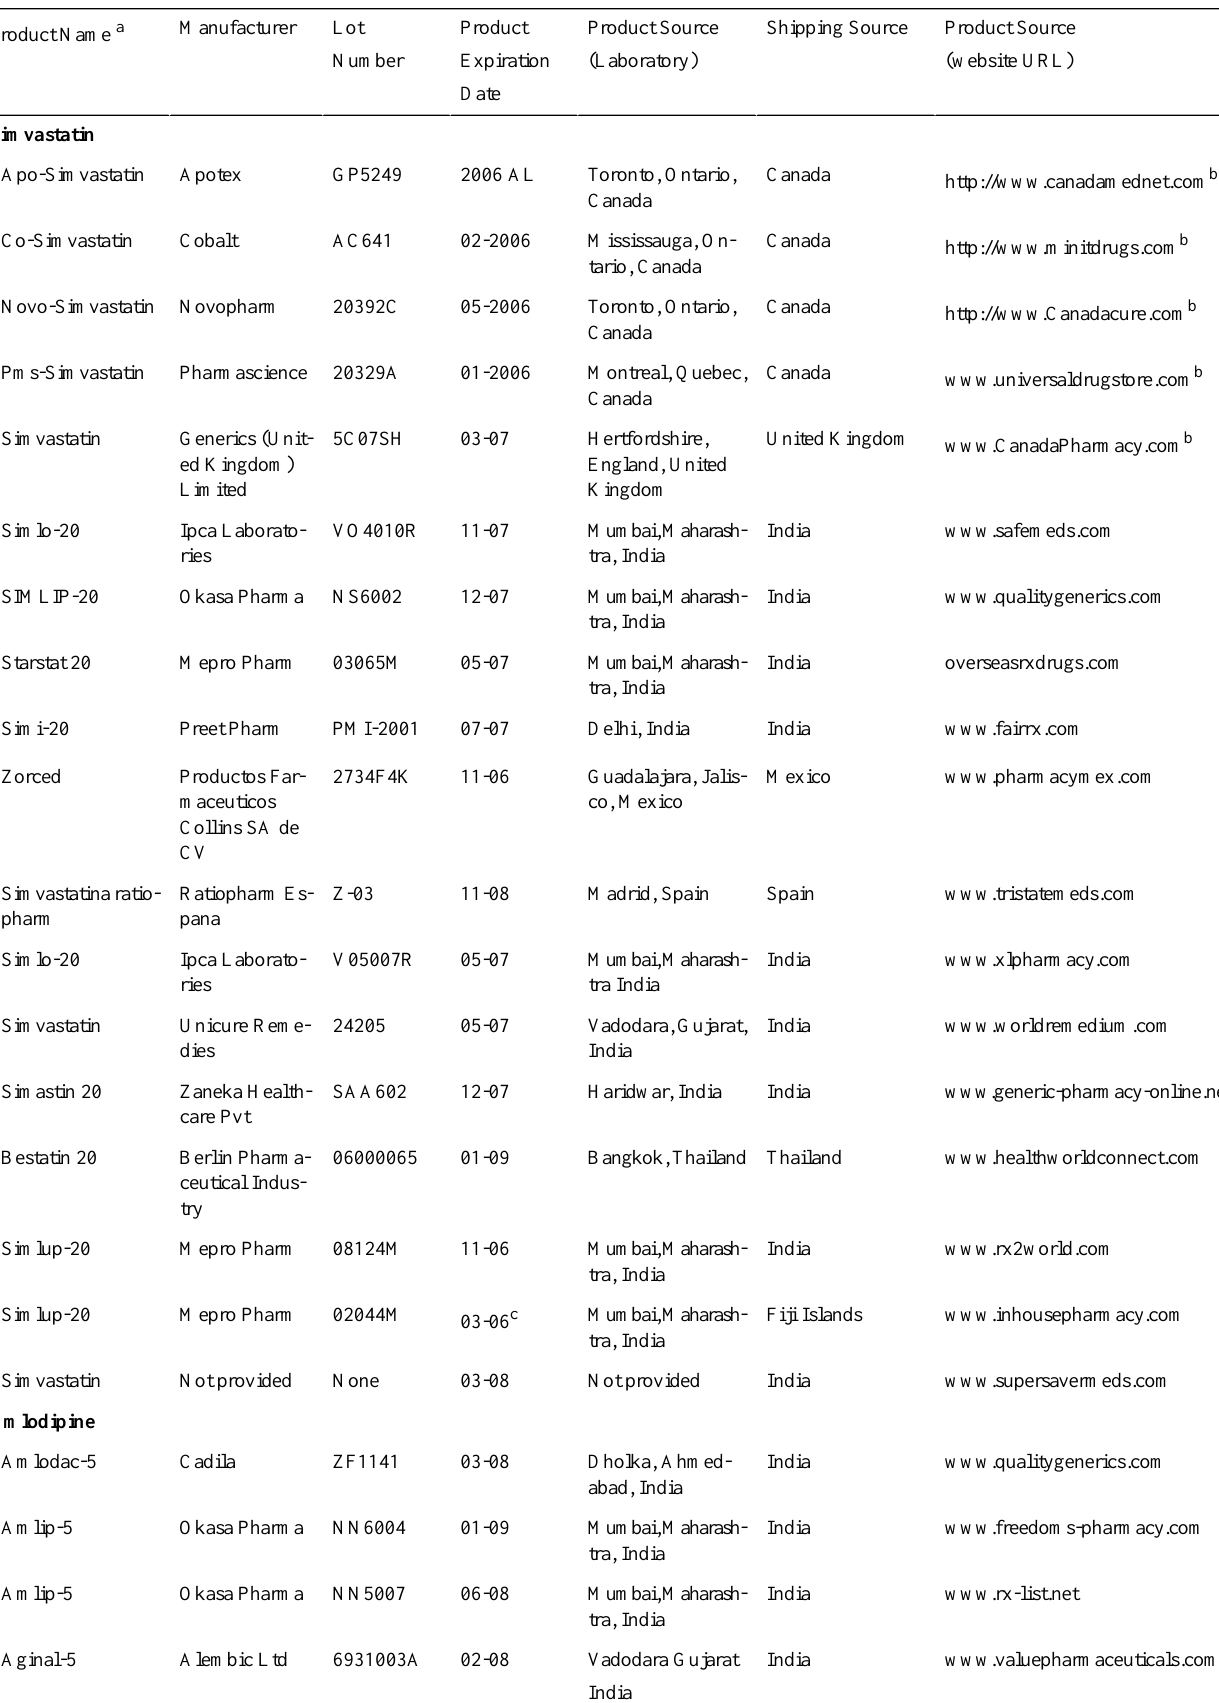
Table 2. Characteristics of pharmaceutical tablet samples from international markets obtained from the Internet